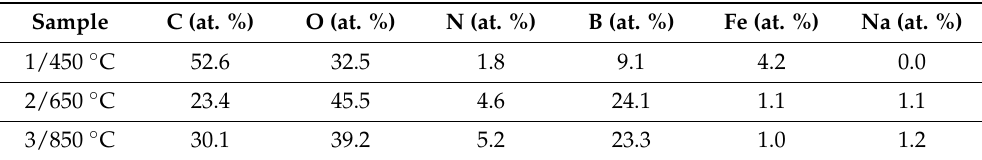
Table 2. Detailed elemental concentration deduced from XPS. Deconvolution of signals from each film constituent used. Sample C (at. %) O (at. %) N (at. %)